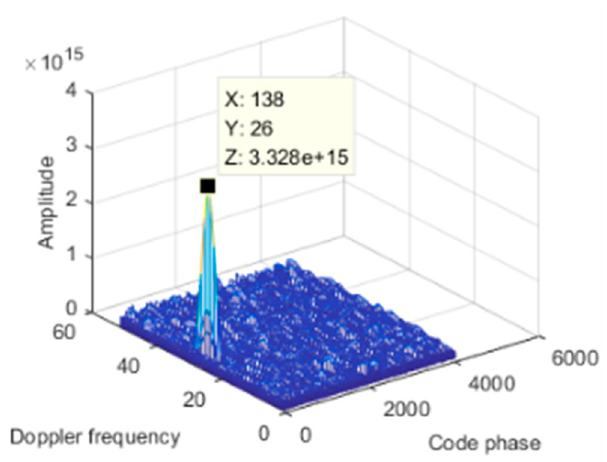
Figure 8. Acquisition result.